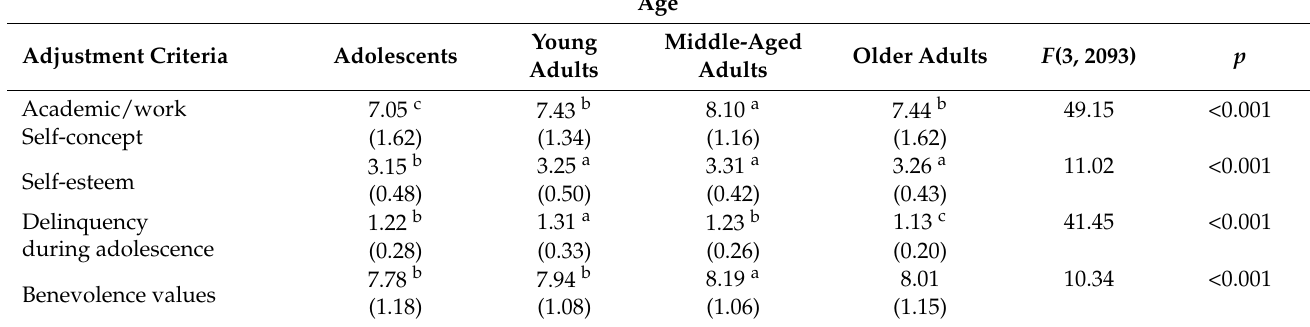
Table 6. Means, standard deviations, univariate F -values, and Bonferroni’s post hoc analysis of age group for academic/professional self-concept, self-esteem, delinquency during adolescence, and benevolence